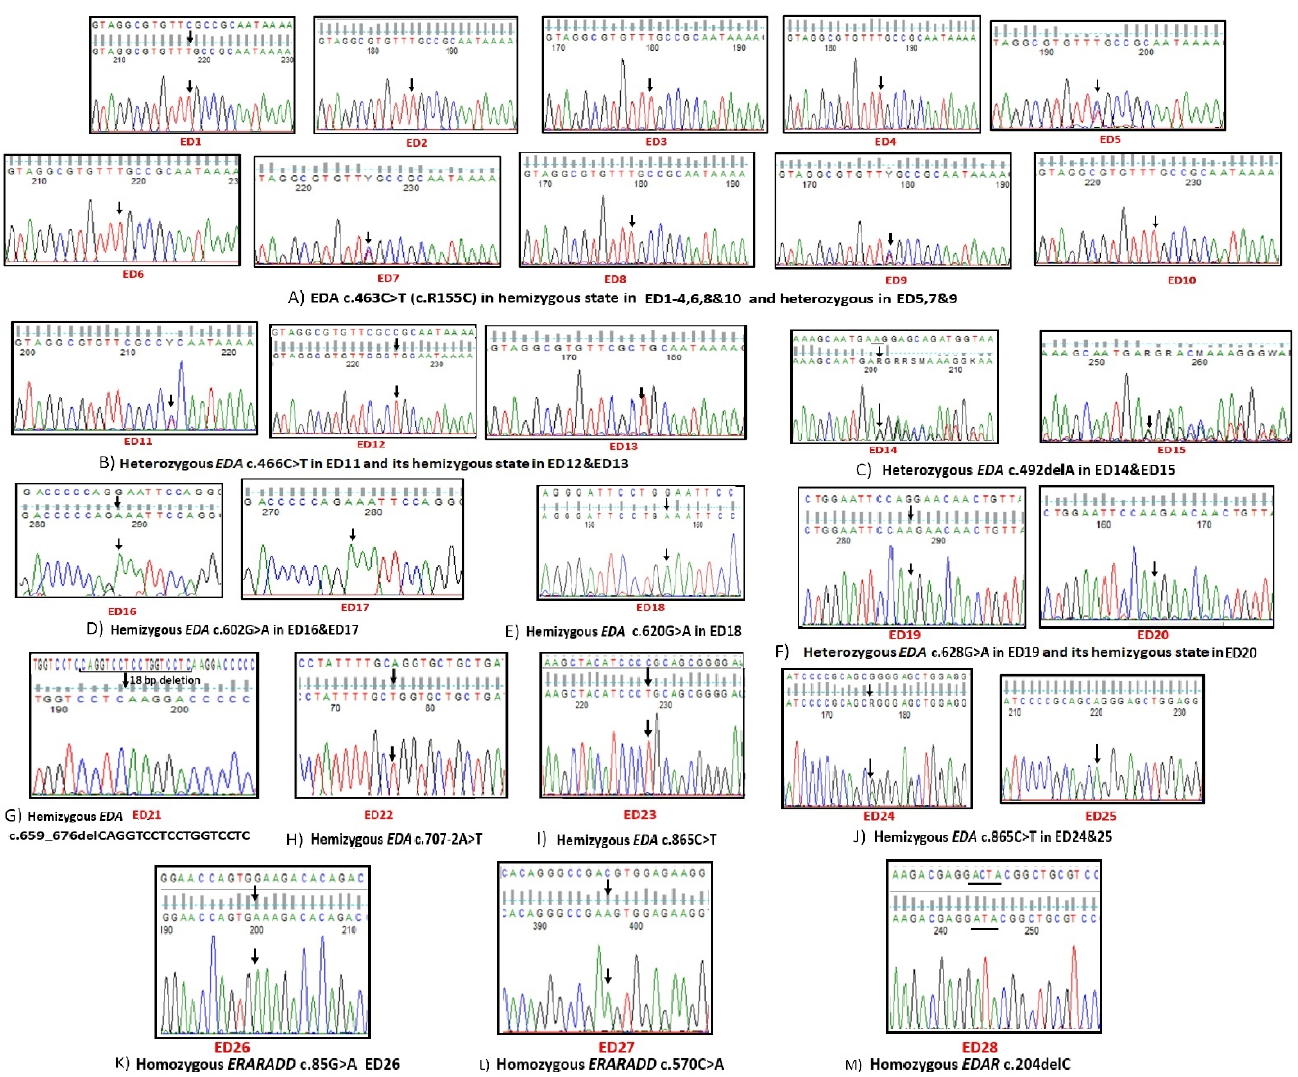
Figure 3. Sequencing chromatograms of 13 mutations identified in EDA , EDARADD , and EDAR . The figure shows 10 EDA (NM_001399.4) mutations ( A – J ), two EDARADD (NM_145861.2) mutations ( K , L ), and one EDAR (NM_022336.3) mutation ( M ). Above each first chromatogram of a given mutation is the wildtype sequence. Black arrows point towards base changes, and deletions are underlined. Below each chart is its corresponding patient number in red.